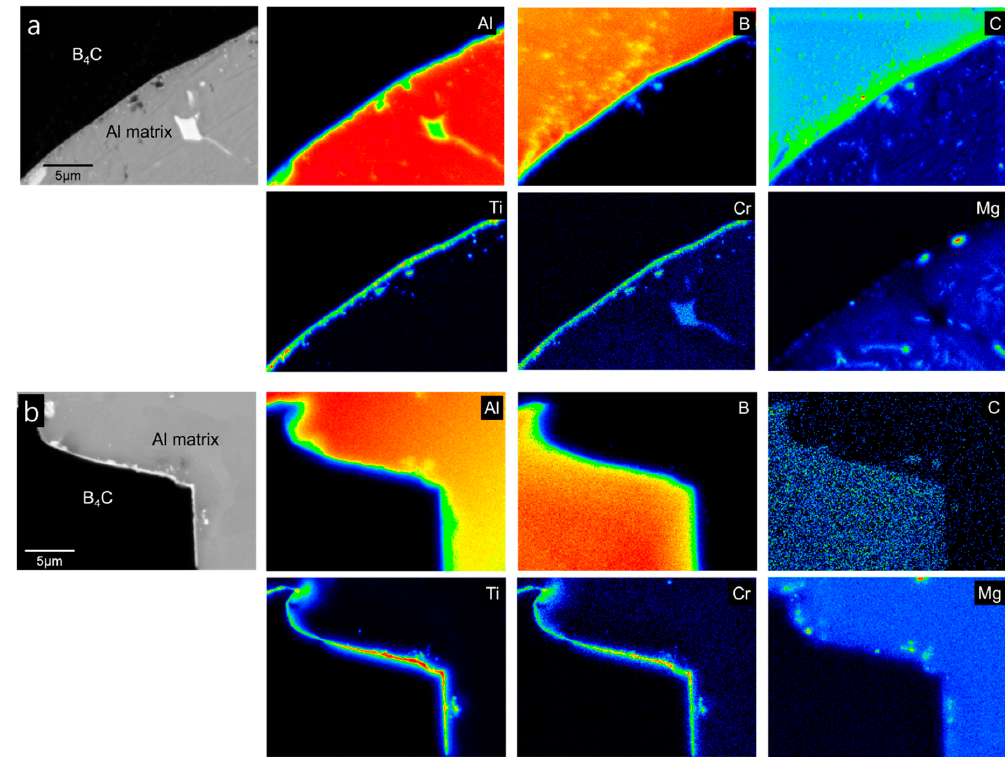
Figure 3. Electron probe microanalyzer (EPMA) analysis of ( a ) B 4 C/Al6061 stir-cast aluminum matrix composites (AMCs) and ( b ) hot-rolled AMCs at 5 vol.% B 4 C.